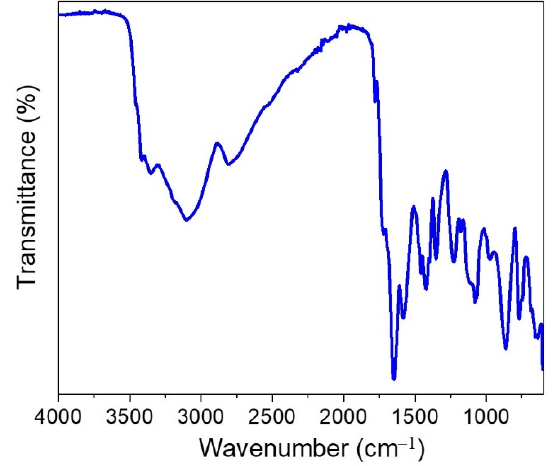
Figure 4. FTIR spectra of g-POCN.